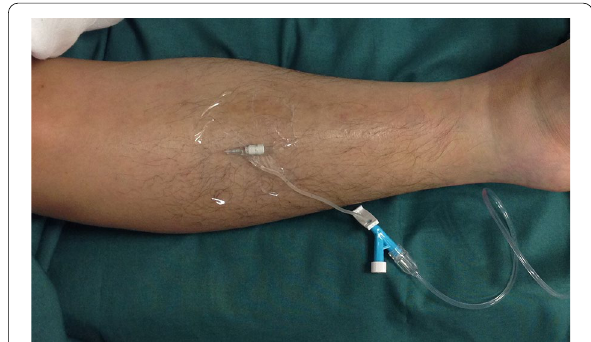
Fig. 2 A 22-gauge intravenous catheter filled with normal saline was inserted into the anterior compartment of the affected limb and connected to an invasive arterial blood pressure monitor system (IABPMS) to measure and monitor the ICP continuously